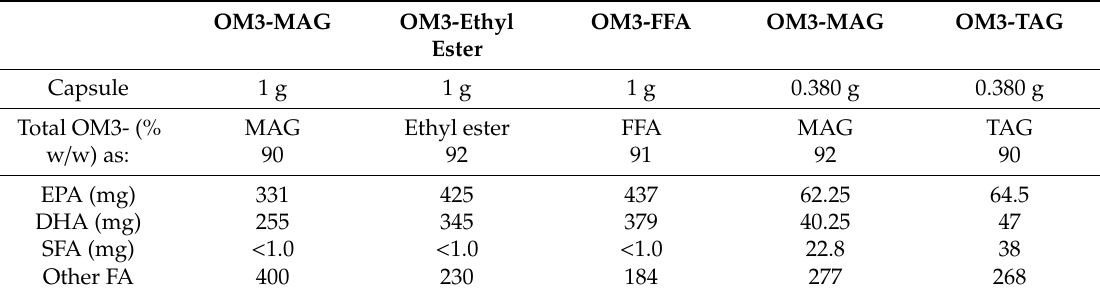
Table 3. FA composition of capsules (in milligrams) before treatment.